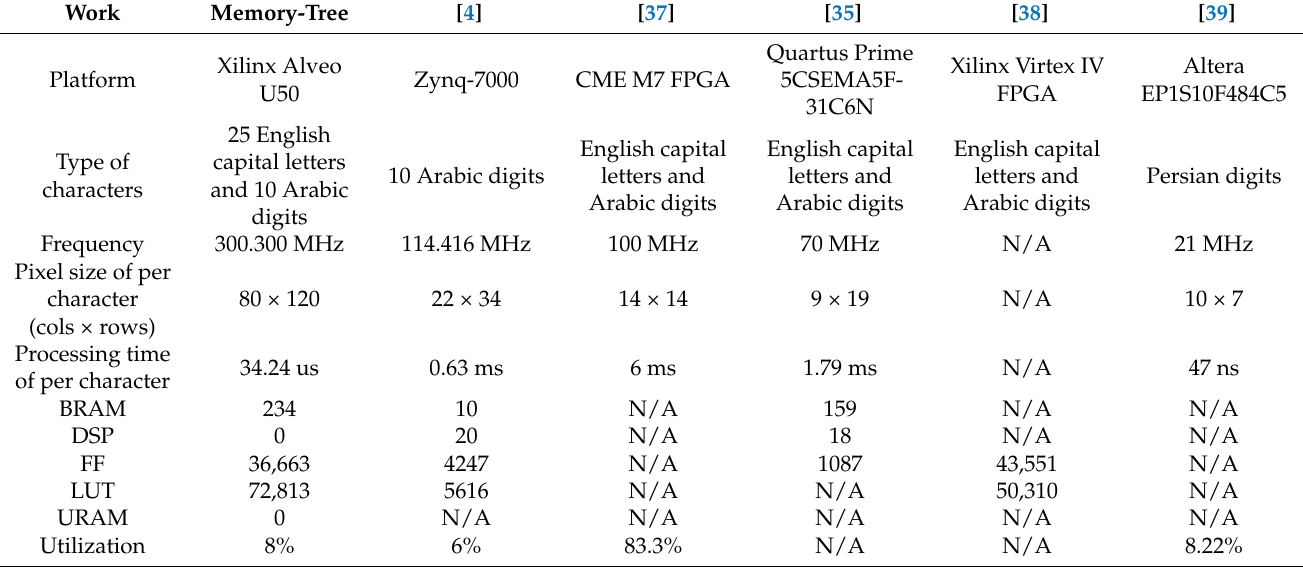
Table 4. Comparison with similar character recognition algorithms in hardware